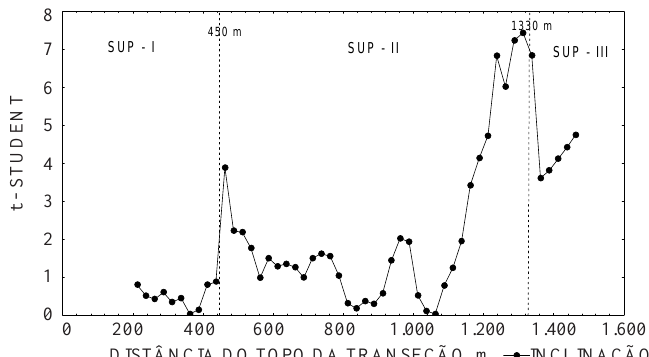
Figura 5. Resultados decorrentes do “Split Moving Windows Dissimilarity Analysis”. Os “picos” mais elevados indicam locais de mudanças mais notáveis da inclinação do terreno (“nick